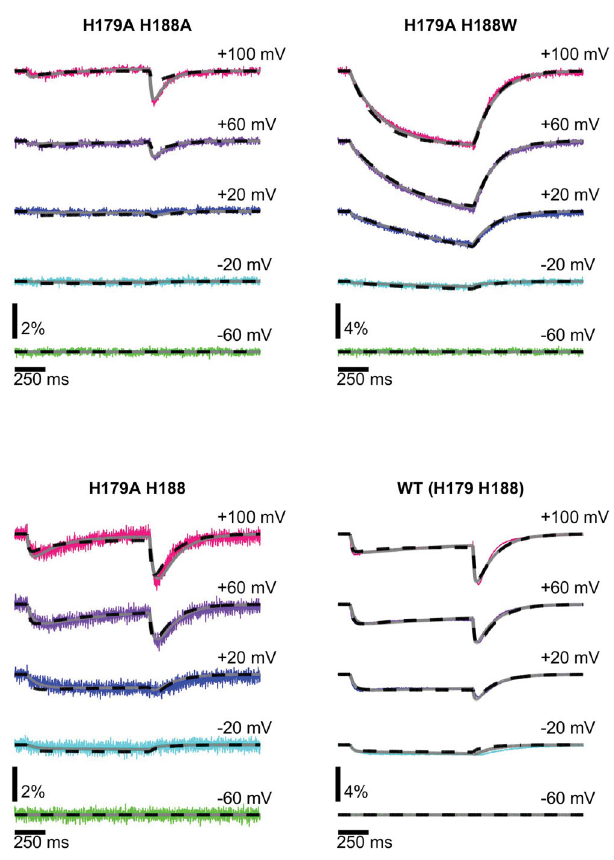
Fig. 8 Experimental and model traces of CiHv1 VCF signals. Fluorescence responses to voltage steps from − 60 mV to + 100 mV (pink), + 60 mV (purple), + 20 mV (dark blue), − 20 mV (light blue) and − 60 mV (green) recorded from oocytes expressing CiHv1 channels labeled with TAMRA- MTS at the E241C position in WT (H179/H188) and different mutants: H179A/H188A, H179A/H188Wand H179A/H188. The fl uorescence signal from these four constructs can be simultaneously described by a single, common three-state kinetic model (dashed black lines), although allowing for kinetic differences between the constructs (grey lines) further improves the agreement between the experiment and